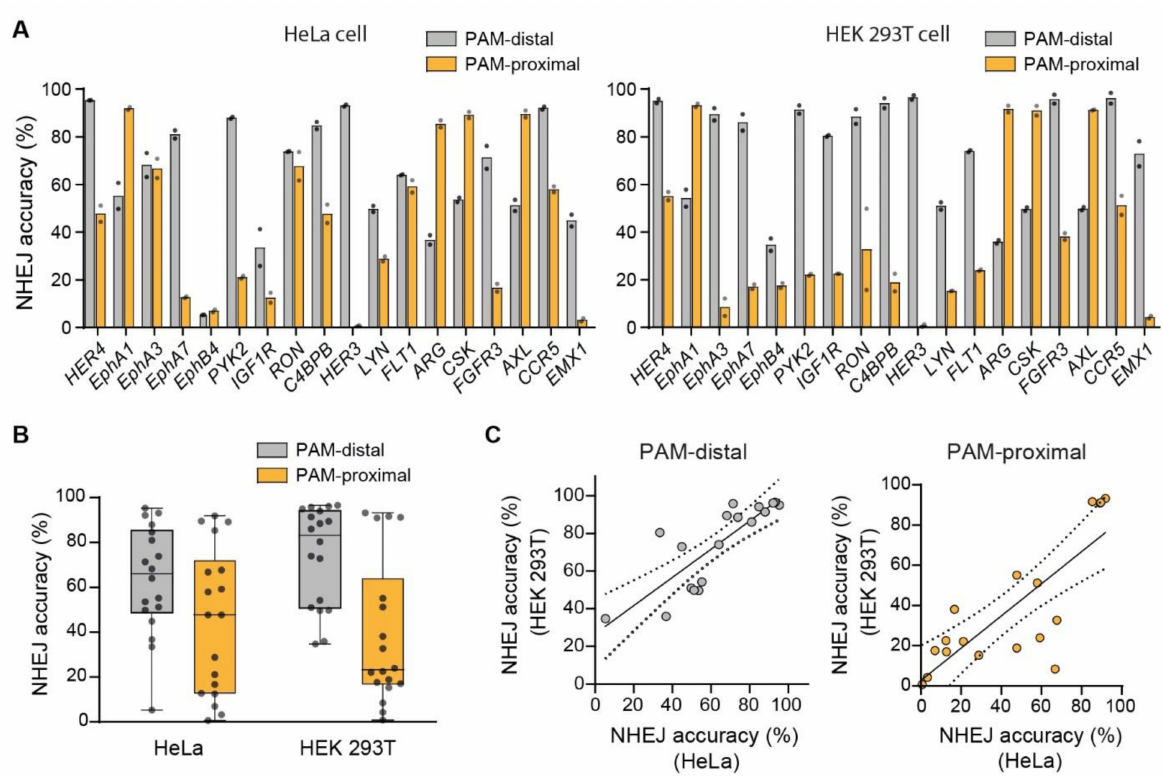
Figure 3. Comparison of NHEJ accuracy between HeLa and HEK 293T cell lines. ( A ) NHEJ accuracy at the PAM-distal end and the PAM-proximal end in HeLa cells and HEK 293T cells. ( B ) Comparison of NHEJ accuracy between the PAM-distal end and the PAM-proximal end in HeLa cells (PAM-distal, 63.44 ± 5.75%; PAM-proximal, 44.76 ± 7.68%; p = 0.07) and HEK 293T cells (PAM-distal, 74.18 ± 5.22%; PAM-proximal, 38.62 ± 7.64%; p < 0.005, Wilcoxon signed rank test) (plot line: median, box: 25–75% percentiles, error bars: range). ( C ) Correlation of NHEJ accuracy at each gene between HeLa cells and HEK 293T cells at the two DSB ends (PAM-distal, R 2 = 0.8576, p < 0.0001, Spearman correlation; PAM-proximal, R 2 = 0.7626, p = 0.0002, Spearman correlation). The linear regression fit is indicated by the solid line with 95% confidence intervals denoted by the dotted